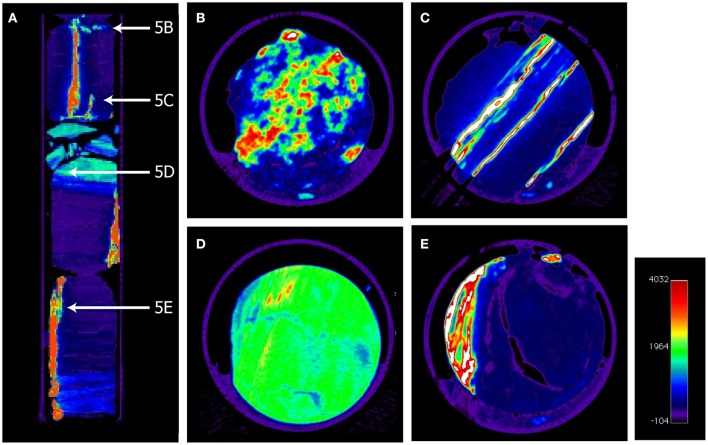
Colored x-ray computer tomography pictures of a 34 cm long core segment of core 30R-2 showing vertical pyrite veins and pyrite granules. (A) Vertical picture with indications of the positions of horizontal panels (B–E). (B) Patchy pyrite precipitates, (C) Multiple vertical pyrite veins, (D) Mud-coal interface with small pyrites, (E) multiple pyrite veins in coal cavities.